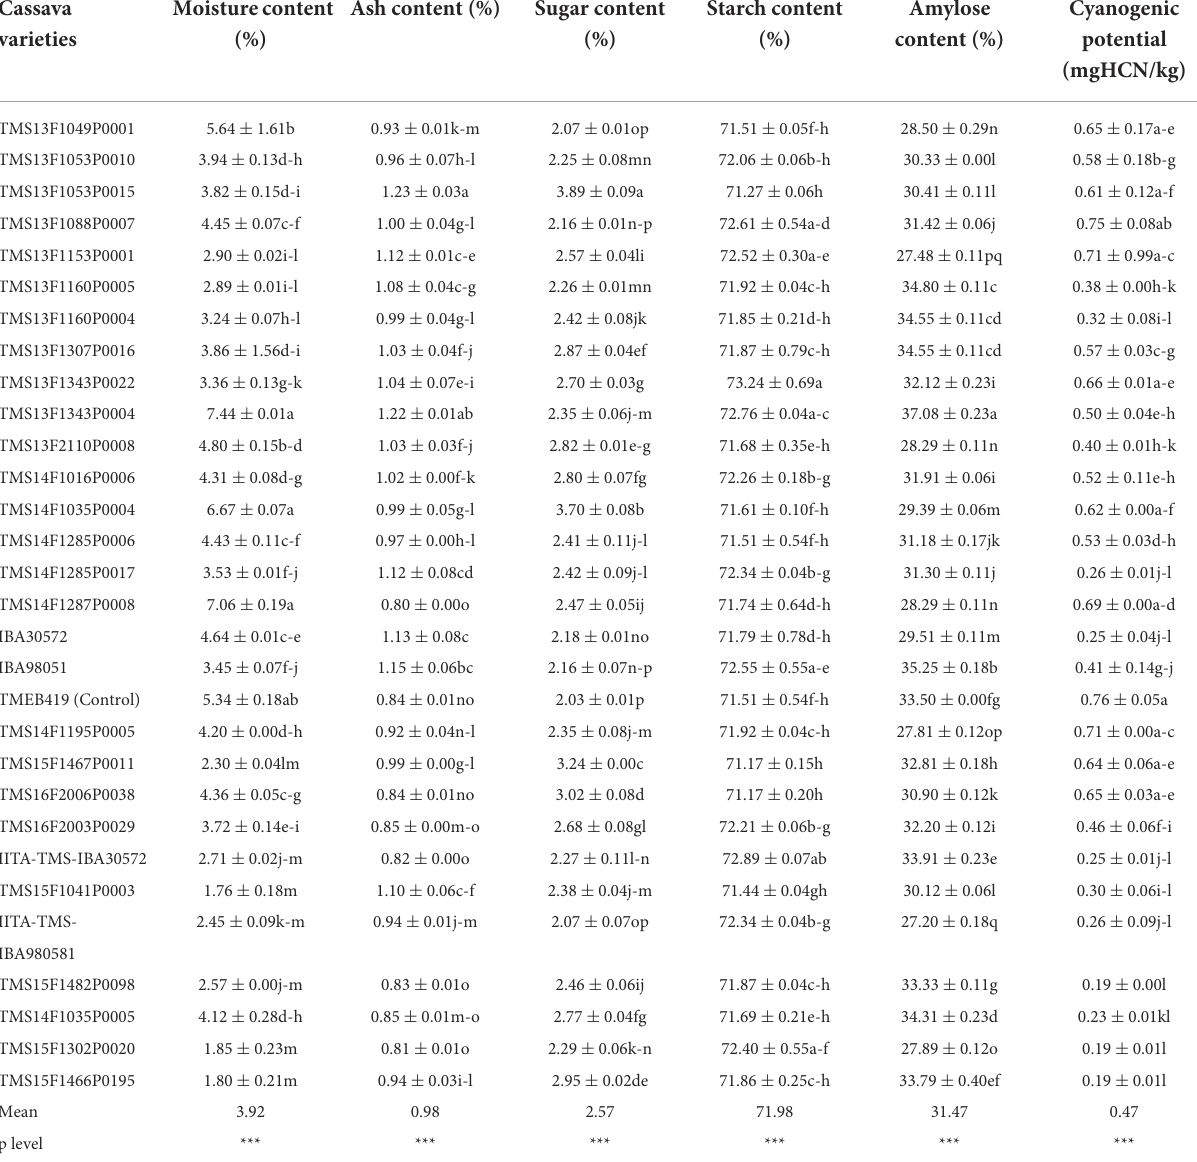
TABLE 4 The chemical composition of gari produced from the cassava genotypes and the control variety.